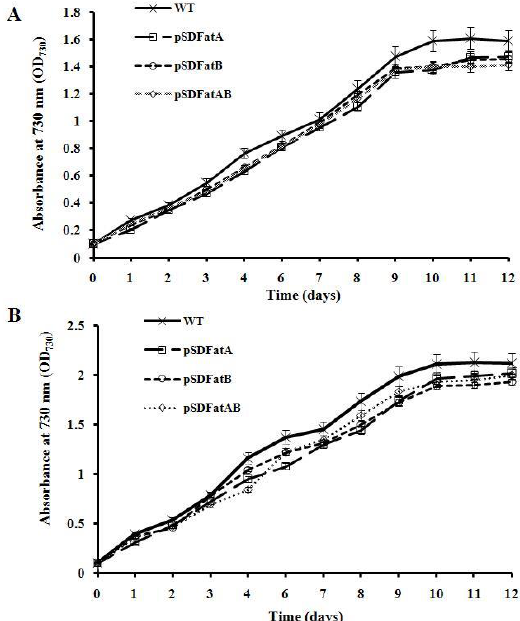
Figure 4. Growth curves of wild-type and transgenic Synechocystis. Cells were grown under mixotrophic conditions at ( A ) 20 °C or ( B ) 30 °C. Cultures were grown in BG-11 medium and bubbled with air under an illumination of 40 μmol photon m −2 s −1 . The optical density of cells at 730 nm was measured at the indicated time points. Values are means ± SD (bars) of three independent experiments conducted on different days. Absence of a bar indicates that the SD falls within the symbol.